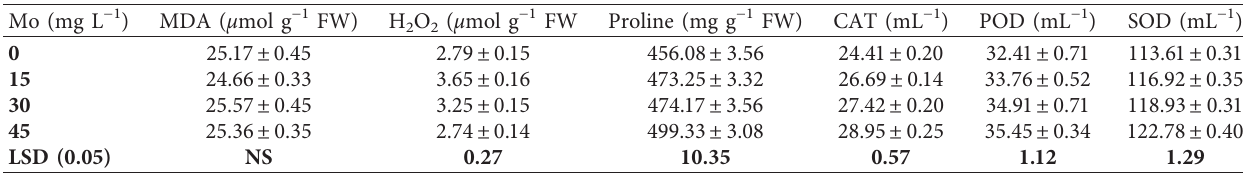
Table 4: Impact of Mo application on some biochemical traits of the mung bean crop growing under water stress conditions (Means ± SE). Mo (mg L − 1